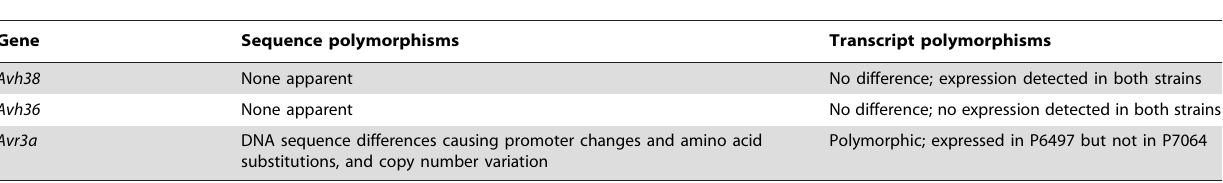
Table 1. Summary of Avr5 candidate genes in P.sojae strains P6497 and P7064 1 .